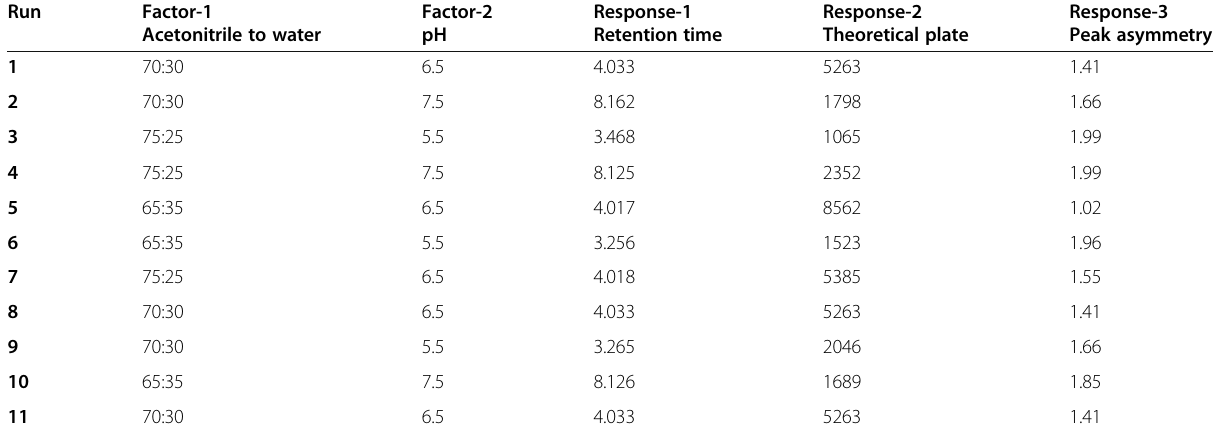
Table 2 Optimization of parameters for analysis of ceftriaxone sodium using CCD Run Factor-1 Acetonitrile to water